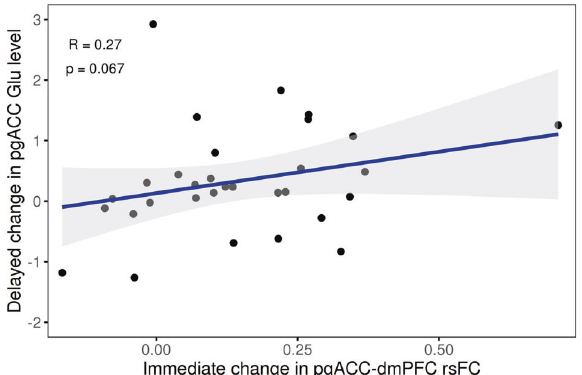
Fig. 5 Correlation between immediate and delayed measures in the pgACC in the S-ketamine arm. A trend-level positive correlation of the immediate rsFC increase (during infusion-baseline) between the pgACC and dmPFC and the delayed pgACC Glu increase (24 h after infusion-baseline) ( n = 31, r p = 0.27, Bonferroni adjusted (for dependent variables) α = 0.04, p = 0.067) was observed. The shaded area represents the 95% con fi dence interval of the fi t. dmPFC dorsomedial prefrontal cortex, Glu glutamate, pgACC pregenual anterior cingulate cortex, rsFC resting-state functional